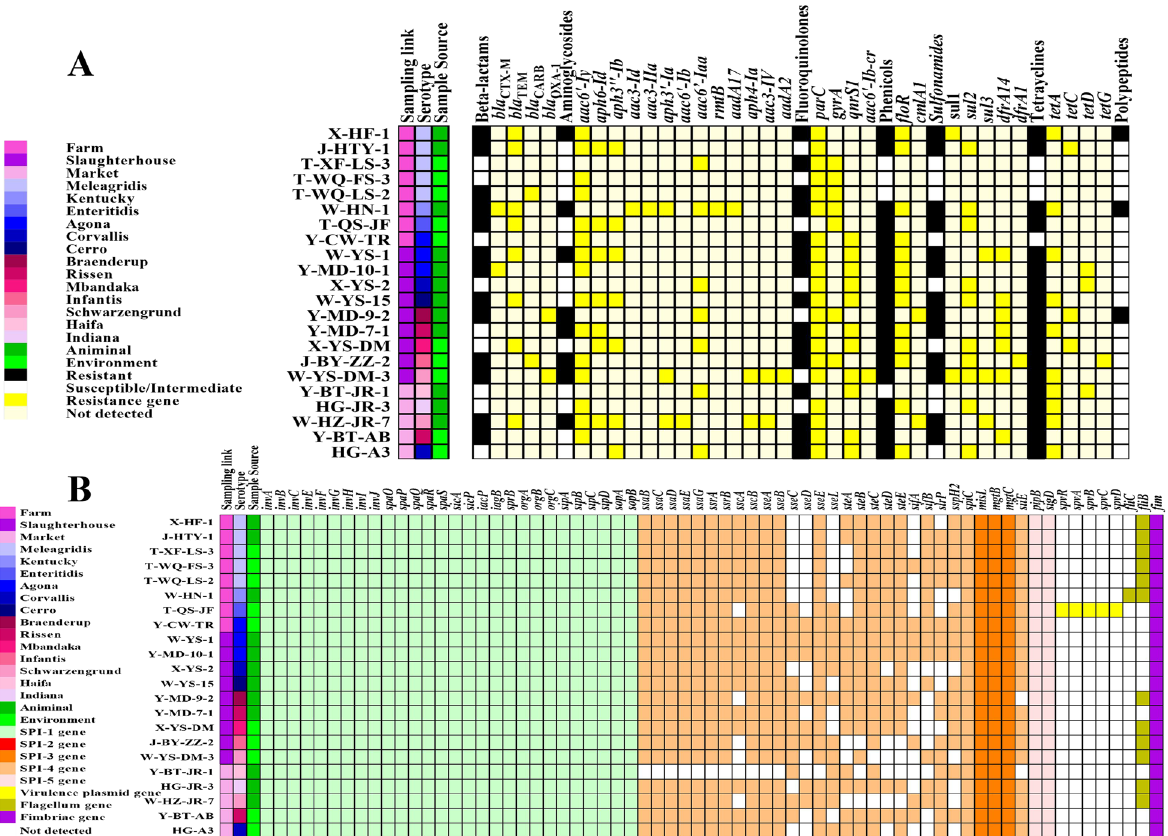
Fig. 4 Distribution of resistance genes ( A ) and virulence genes ( B ) of 22 whole-genome sequenced Salmonella